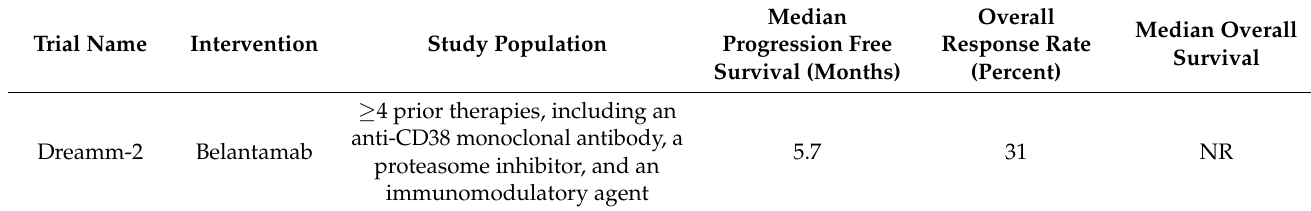
Table 6. Summary of Major Clinical Trials for FDA Approval of